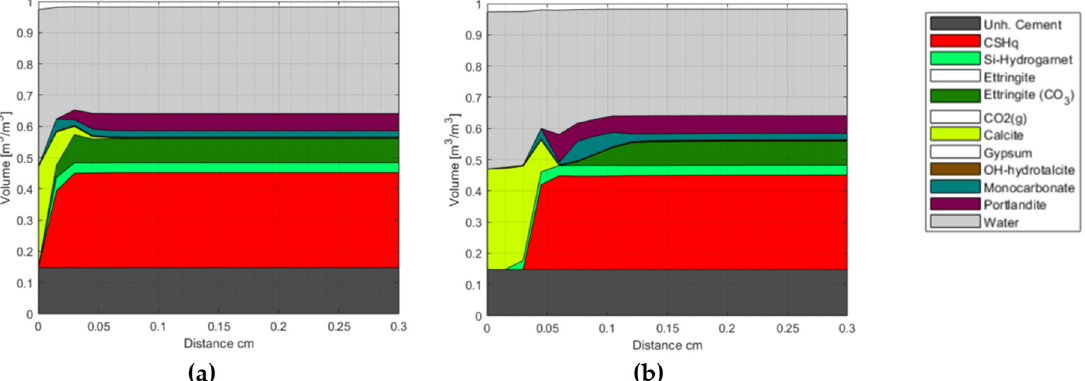
Figure 5. Phase assemblage after ( a ) 1 day and ( b ) 42 days of exposure to 0.5 M NaHCO 3 solution. The unhydrated cement represents the amount of unreacted cement at the time of hydration. The white blocks in the phase assembly legend indicate phases included in the chemical model, but not present at the displayed times.